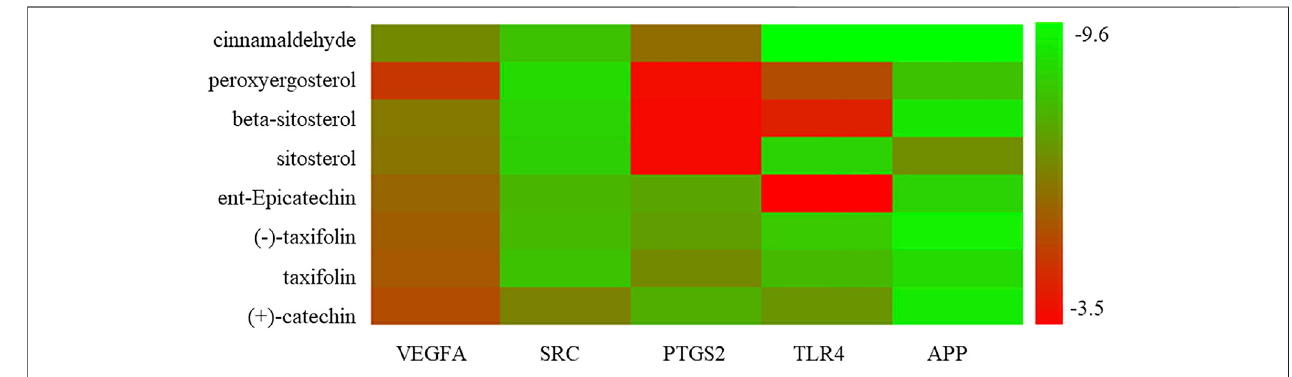
FIGURE 6 | The binding energy of the main active components of Guizhi and the key